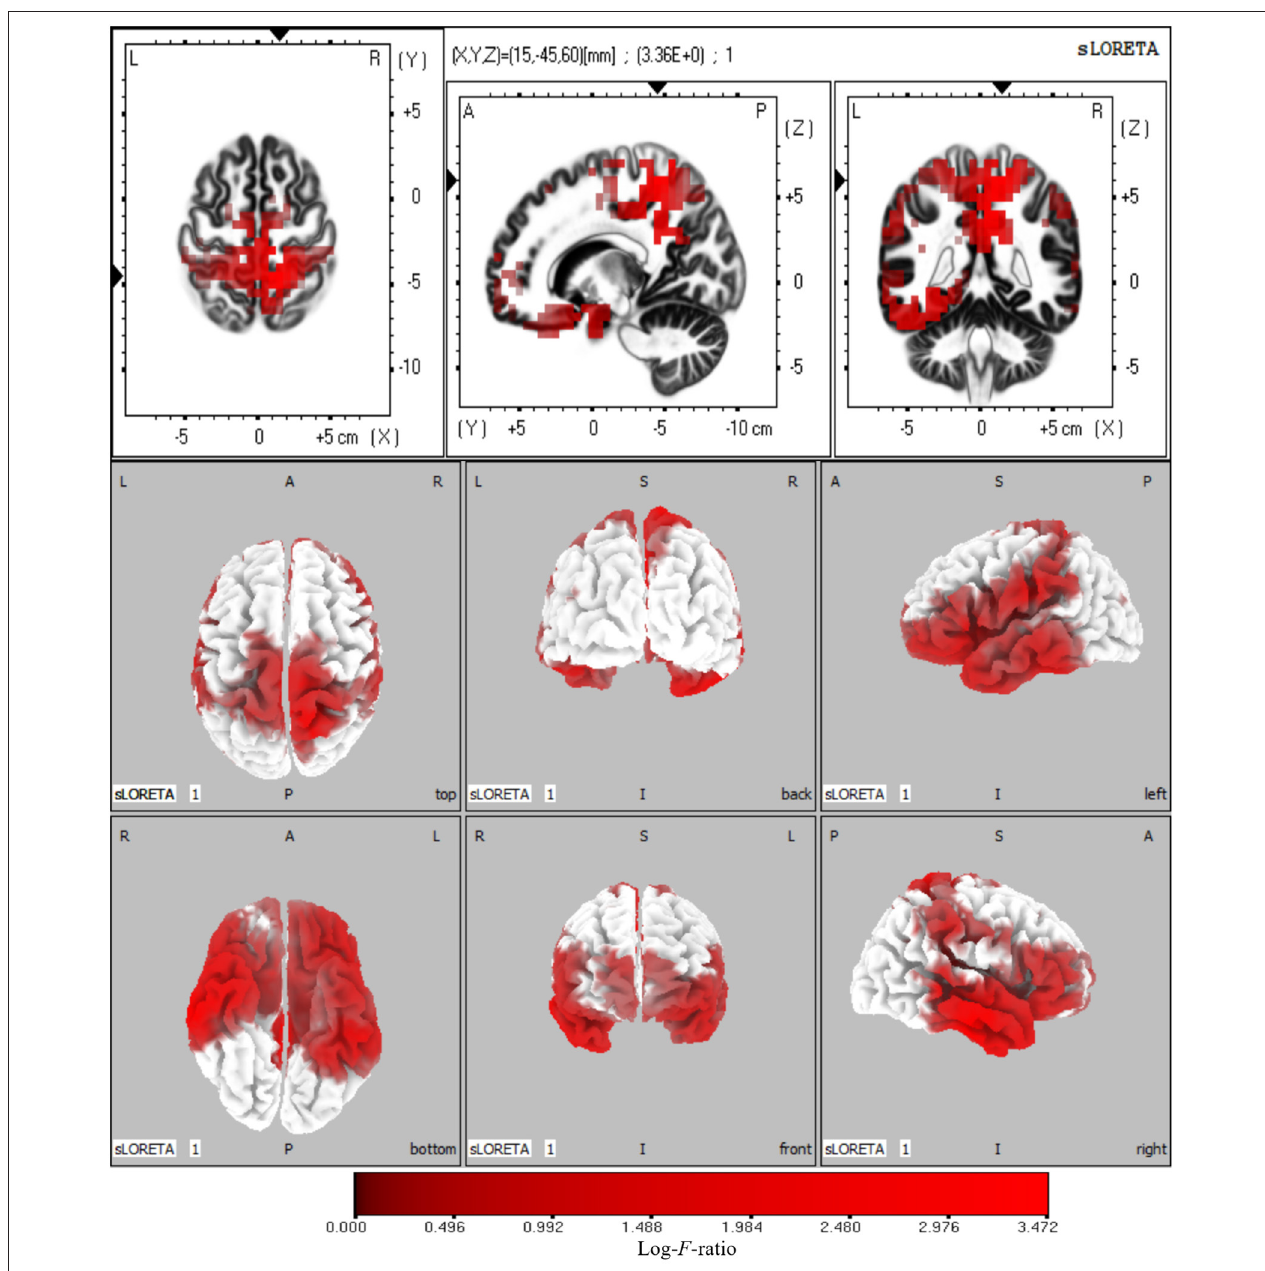
FIGURE 5 | Statistical maps of source locations at theta frequency were projected onto a three-dimensional brain MRI template (top panel) and fiducial cortical surface (bottom panel). Non-parametric permutation test statistical analysis was performed to compare the current density distributions of AV with A + V. Colored areas represent the spatial extent of voxels with a significant difference in the current density. Log- F -ratio statistics were applied, and the color scale represents log- F -ratio values (threshold log- F -ratio = 3.36, p < 0.05). The MRI slices are located at MNI-space coordinates. In the averaged time windows of theta activity (110–260ms), the maximum current density differences were found in the left superior frontal gyrus (Brodmann area 8, MNI: − 30 20 50), right precuneus (Brodmann area 7, MNI: 5 − 40 45), right inferior temporal gyrus (Brodmann area 21, MNI: 65 − 15 − 20), right cuneus (Brodmann area 18, MNI: 20 − 95 20). The color scale represents the log- F -ratio values of current source density (threshold: log- F -ratio = 3.36, p < 0.05). A, anterior; P, posterior; S, superior; I, inferior; L, left; R, right.